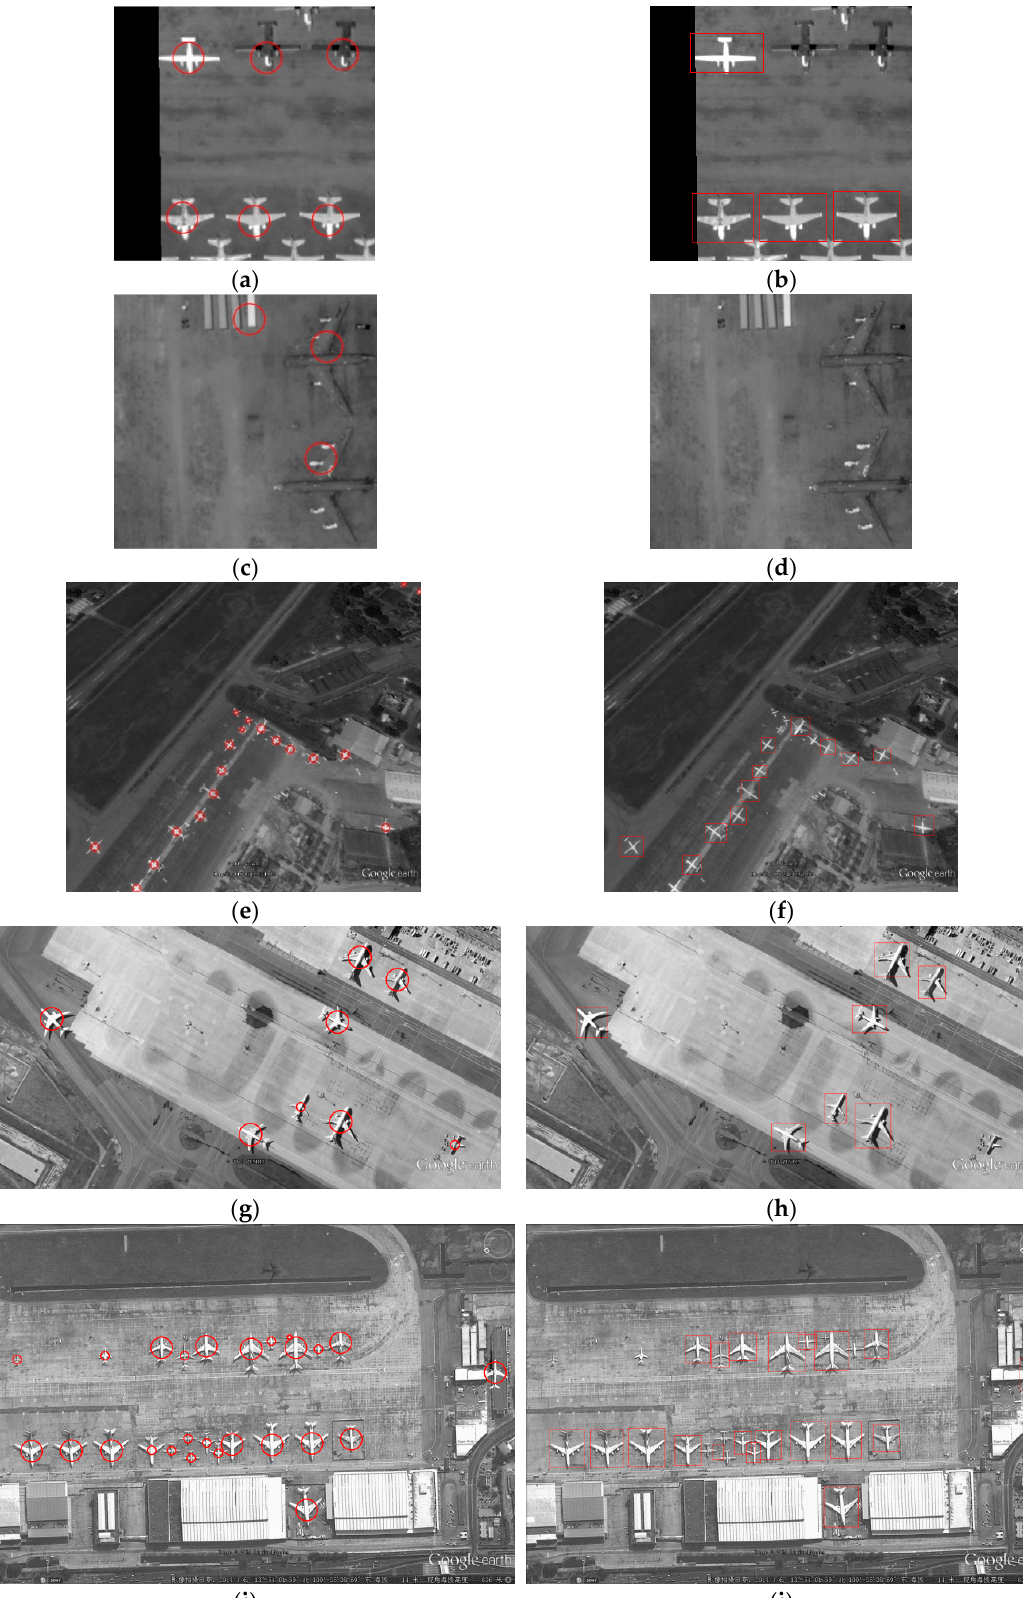
Figure 7. ( a , c , e , g , i ) are the detection results of the proposed method; ( b , d , f , h , j ) are the detection results of Faster R CNN.